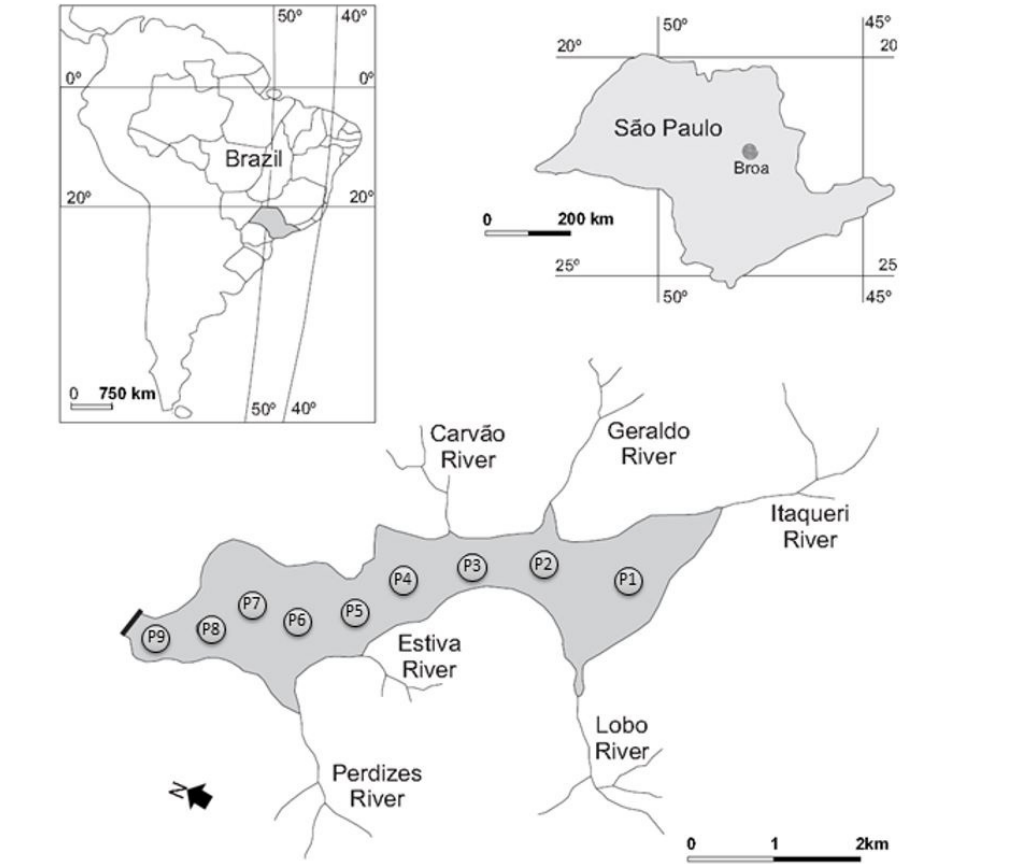
Figure 1. Representation of the sampling points (P1 to P9) in the Broa reservoir and its respective tributaries, located in the State of São Paulo, Brazil. The different shades of gray highlighting the following sets of sample points (P1 – P3; P4 – P6; and P7 – P9) indicate the theoretical zones of river, center and dam, respectively. From: Adapted from Tundisi et al.